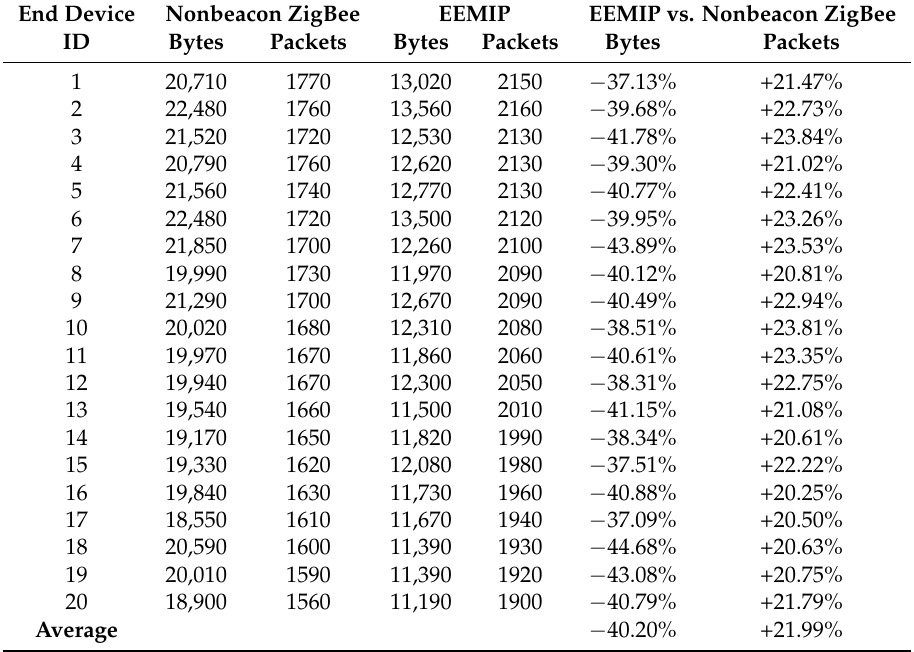
Table 9. Comparison of the two simulation modes for a more realistic scenario.